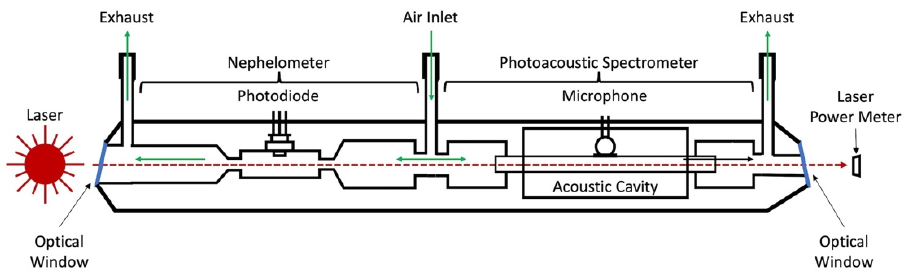
Figure 1. A schematic of an extinctiometer, combining a nephelometer and a photoacoustic spectrometer. The green arrows show the airflow. The instruments’ manual indicates a nominal flow rate of 1.0 L/min ± 10% at 21 °C and 1 atm.